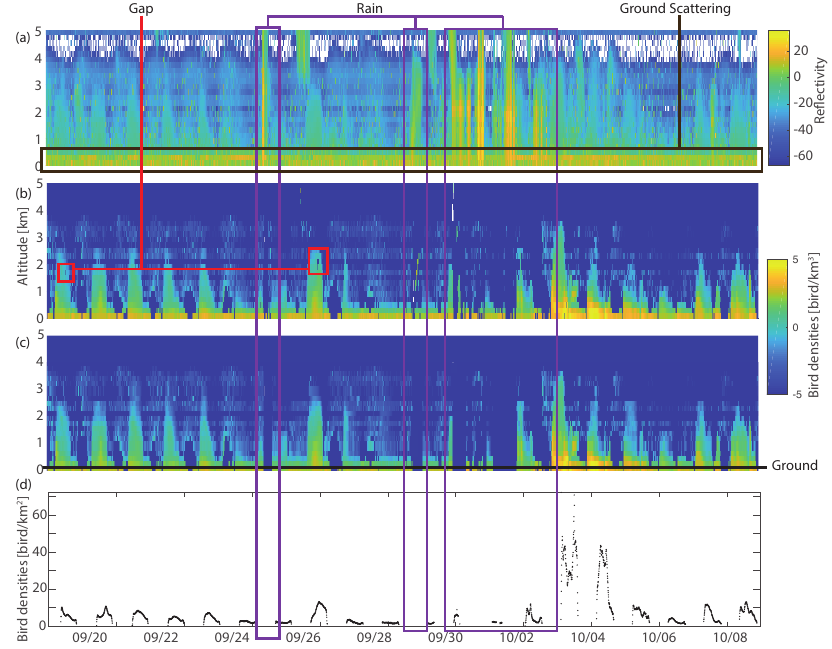
Figure A1. Illustration of the cleaning procedure for the data of the Zaventem radar in Belgium (50 ◦ 54 (cid:48) 19 (cid:48)(cid:48) N, 4 ◦ 27 (cid:48) 28 (cid:48)(cid:48) E). ( a ) Raw reflectivity. ( b ) Raw data of vertical bird density profiles. ( c ) Manually cleaned vertical bird profiles. ( d ) Final bird densities (integrated over all